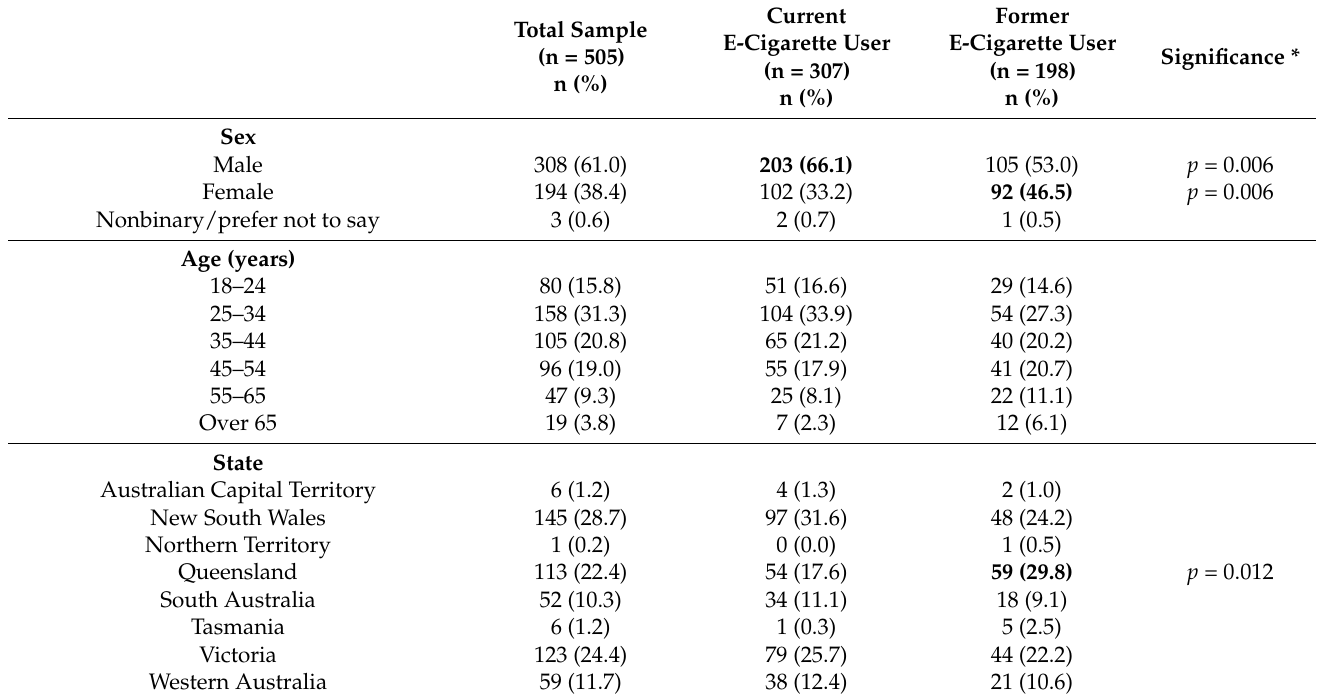
Table 1. Study participant demographics. Numbers in bold indicate significantly greater than expected compared with current or former user for the same